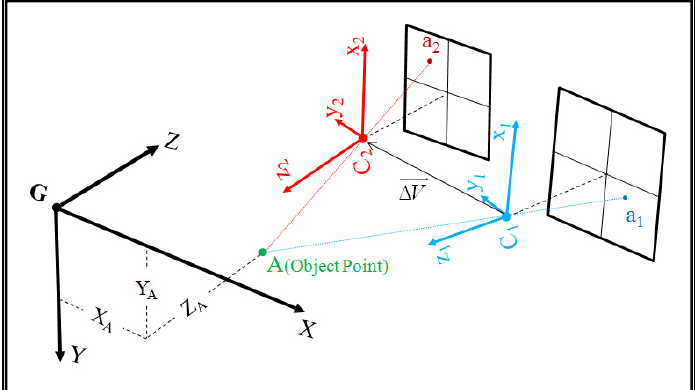
Figure 2. Coordinate systems and their